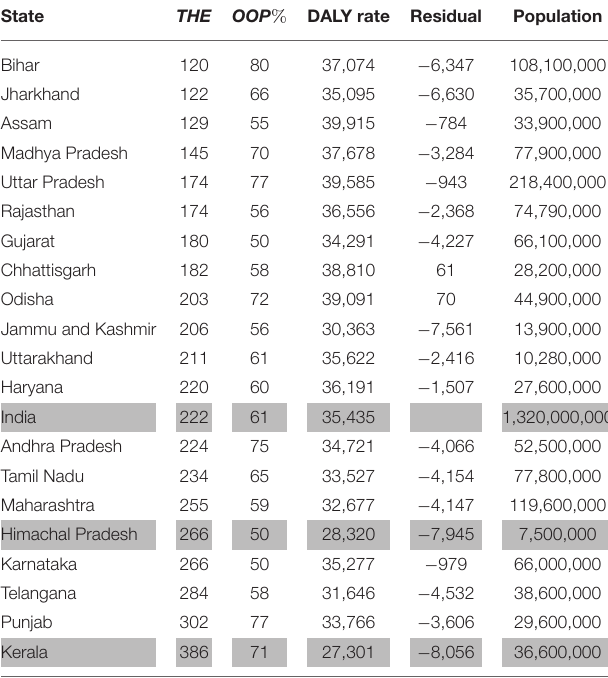
TABLE 10 | Indian